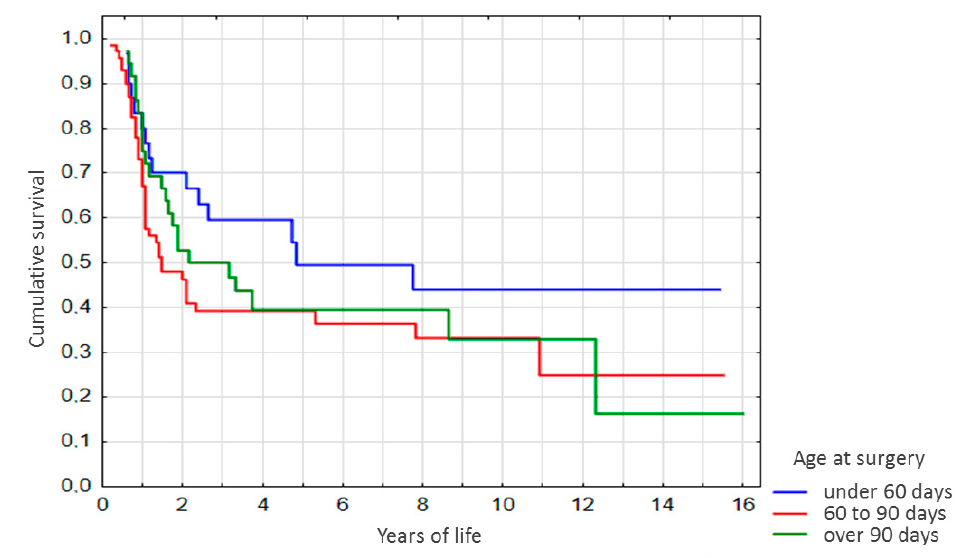
Figure 4. Survival curves for the non-LT subgroup with advanced stratification by age at Kasai